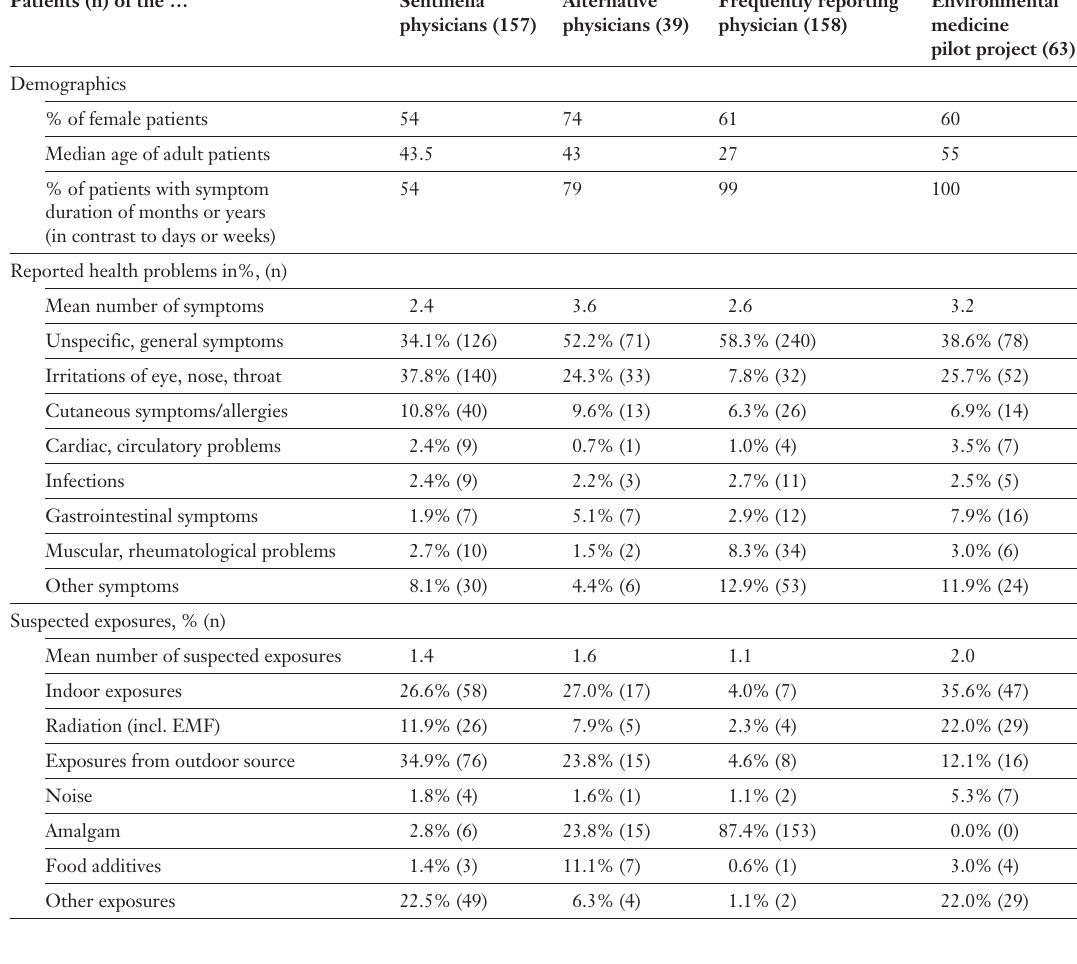
Table 2 Comparison between patients of the Sen- tinella physicians, “alternative” physi- cians and the envi- ronmental medicine pilot project: demo- graphics, reported symptoms and suspected environ- mental exposures.